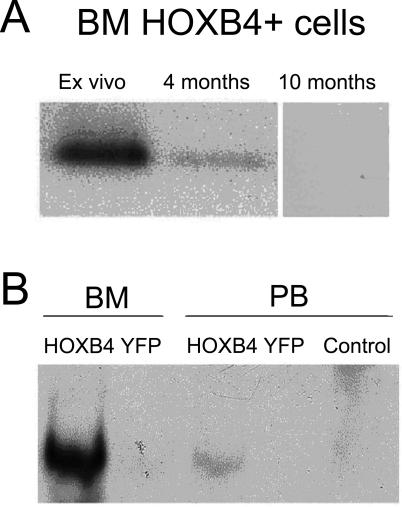
HOXB4 Protein Expression in HOXB4-Marked Cells(A) HOXB4-transduced CD34
+ cells (lane 1) or FACS-sorted HOXB4GFP
+ bone marrow cells from M01035 at 4 mo (lane 2) or 10 mo post-transplantation (lane 3) were subjected to Western blot for detection of HOXB4 expression levels.
(B) HOXB4GFP
+ or YFP
+ cells from bone marrow or peripheral blood in M01035 were isolated and subjected to Western blot analysis. Protein lysate of peripheral blood cells from a normal control animal was used as a negative control.